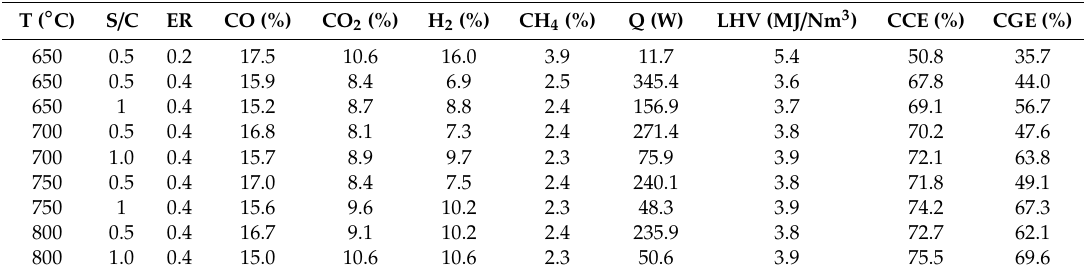
Table 7. Cases satisfied self-su ffi ciency in sensitivity